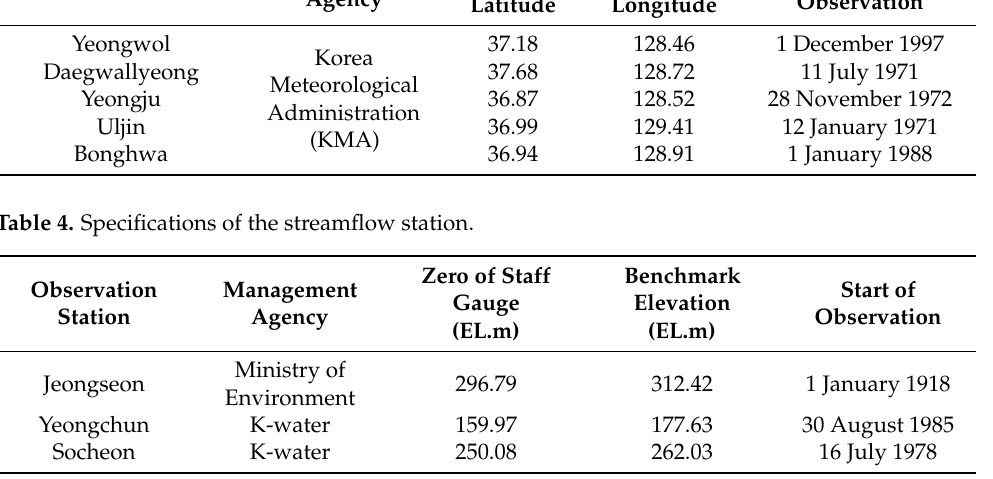
Table 3. Specifications of the rainfall stations. Observation Station